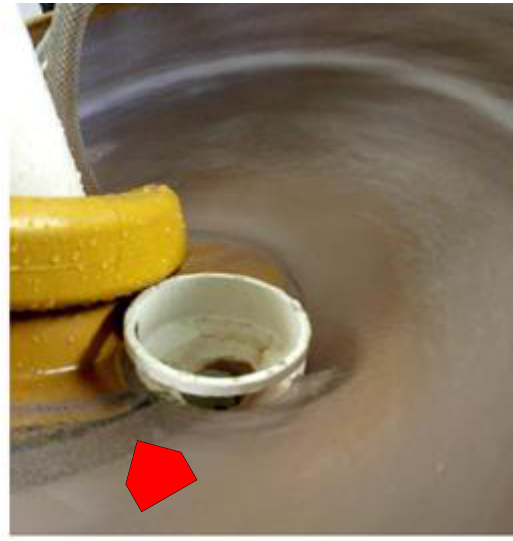
Figure 3. Apatite captured by a cutter of the spiral.